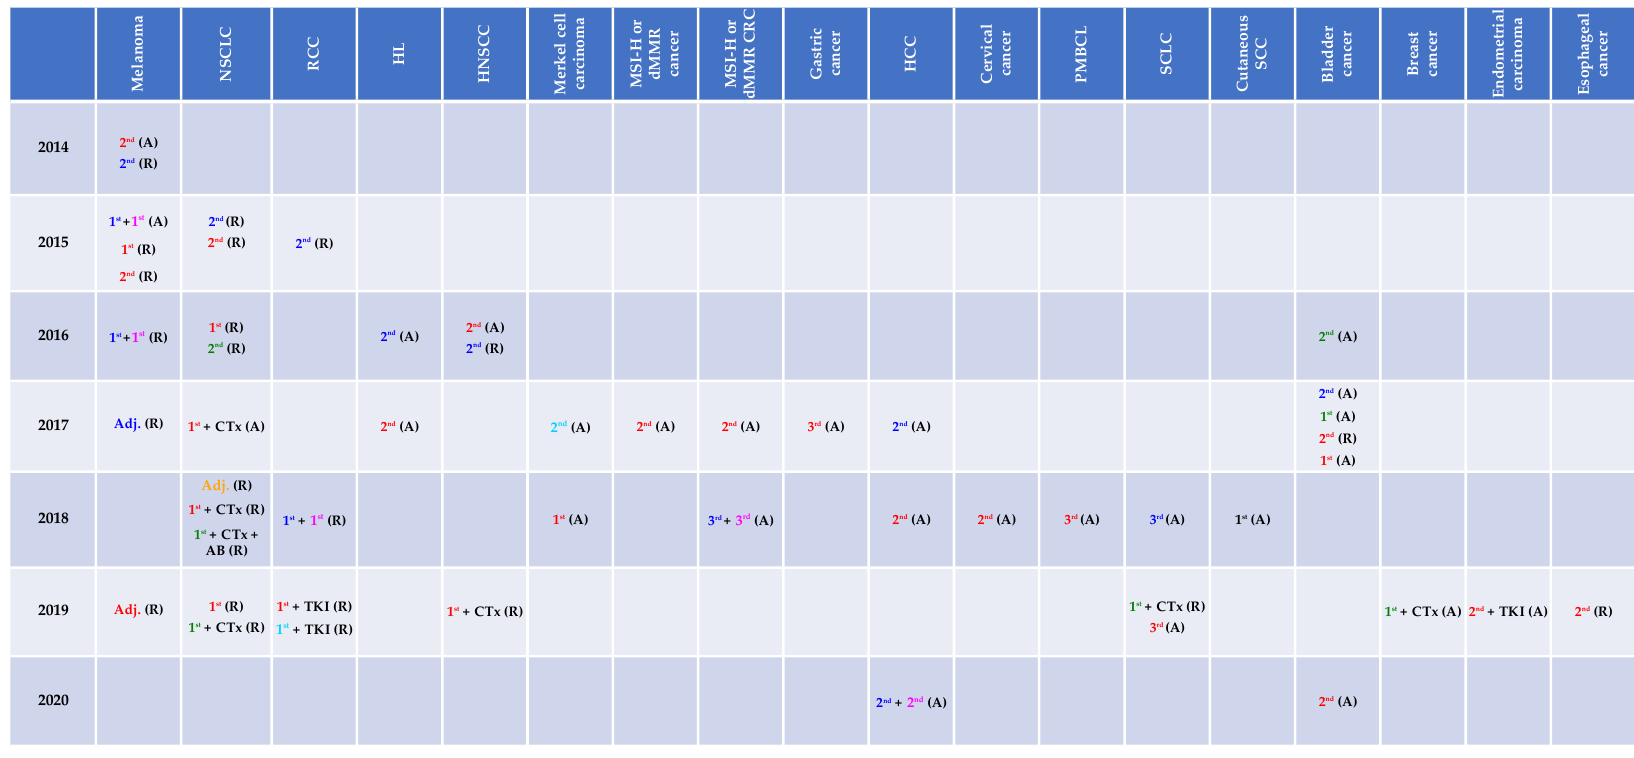
Color(cid:9)code:(cid:9)nivolumab,(cid:9)pembrolizumab,(cid:9)ipilimumab,(cid:9)atezolizumab,(cid:9)durvalumab,(cid:9)avelumab,(cid:9)cemiplimab.(cid:9) Figure 1. Immune-checkpoint inhibitor approval status by the Food and Drug Administration (access date: 03/13/2020). A: accelerated, AB: antibody, CTx: chemotherapy, dMMR: mismatch repair deficiency, HCC: hepatocellular carcinoma, HL: Hodgkin’s lymphoma, HNSCC: head and neck squamous cell carcinoma, MSI-H: microsatellite instability, NSCLC: non-small cell lung cancer, PMBCL: primary mediastinal B cell lymphoma, R: regular, RCC: renal cell carcinoma, TKI: tyrosine kinase inhibitor.